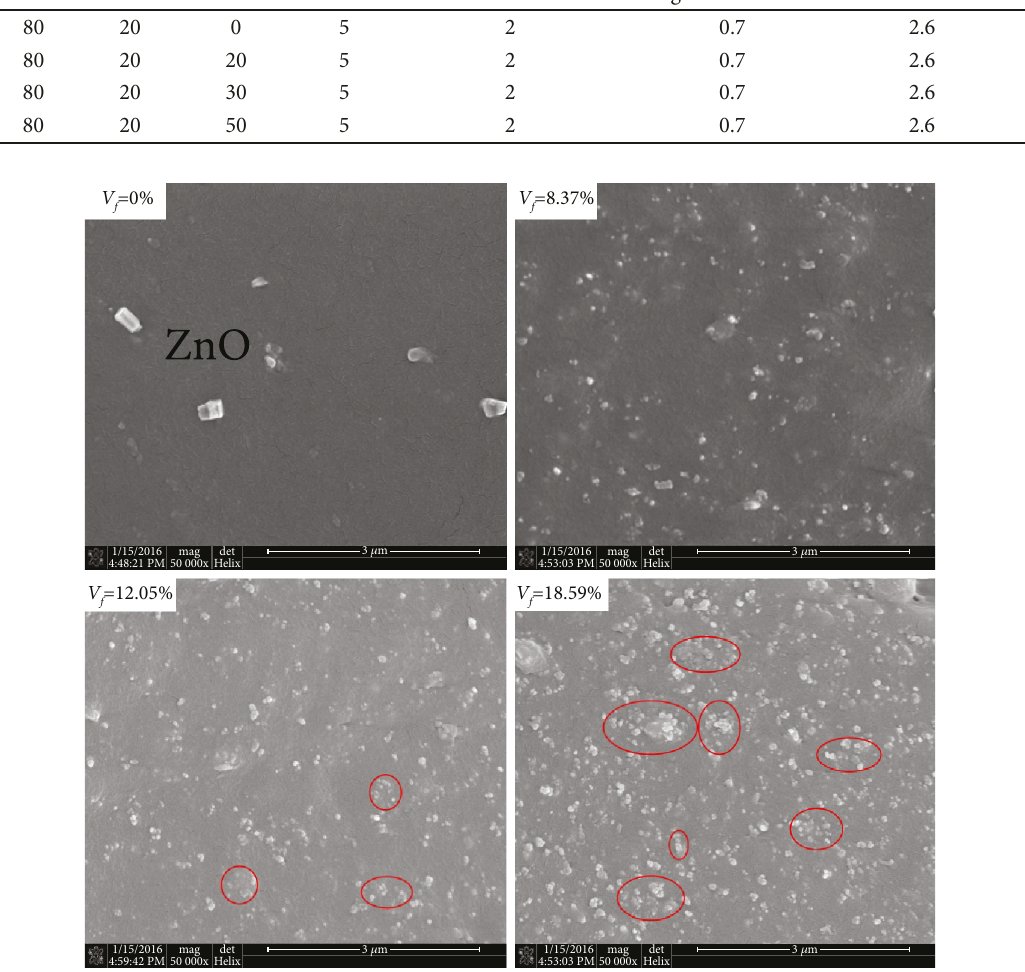
Figure 1: SEM photos of rubber composites with di ff erent carbon black volume